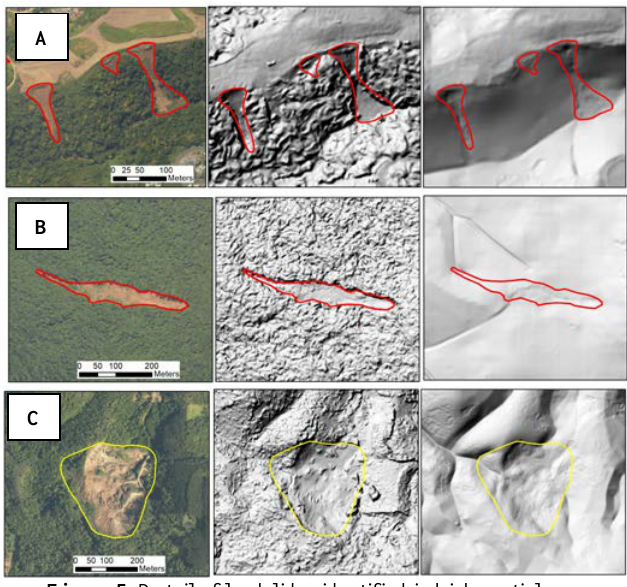
Figure 5. Detail of landslides identified in high spatial resolution aerial photographs and in shaded relief images derived from DSM and